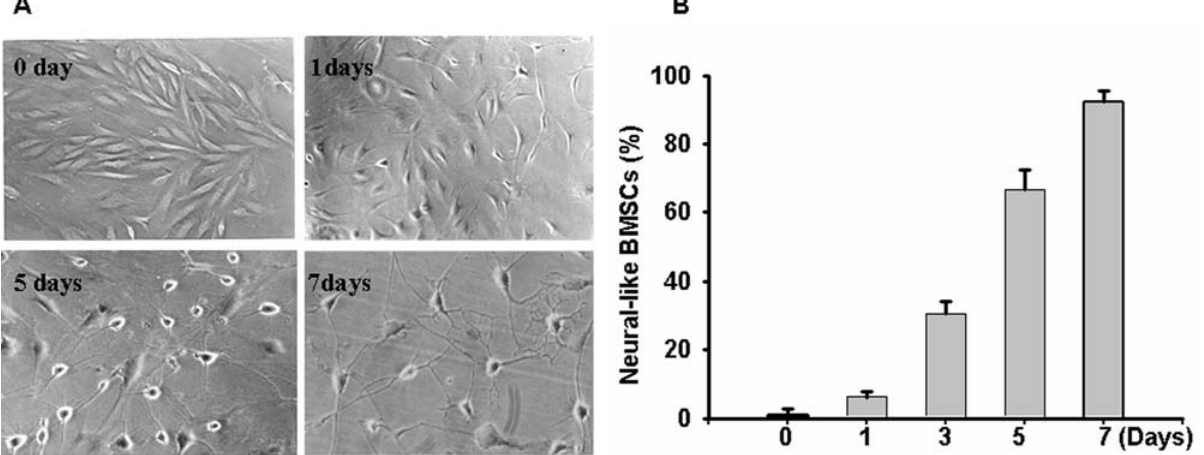
Figure 1. The morphology of the BMSCs after co-culturing. A , The morphological changes of BMSCs over 7 days (10 6 ); B , The bar graph demonstrates that the percentage of neural-like BMSCs increases when co-cultured with RGCs. p # 0.05 at all time points. (10 pictures were taken randomly under a regular microscope from culturing cells at different time points. The average relative percent of neural-like BMSCs come from at least three separate